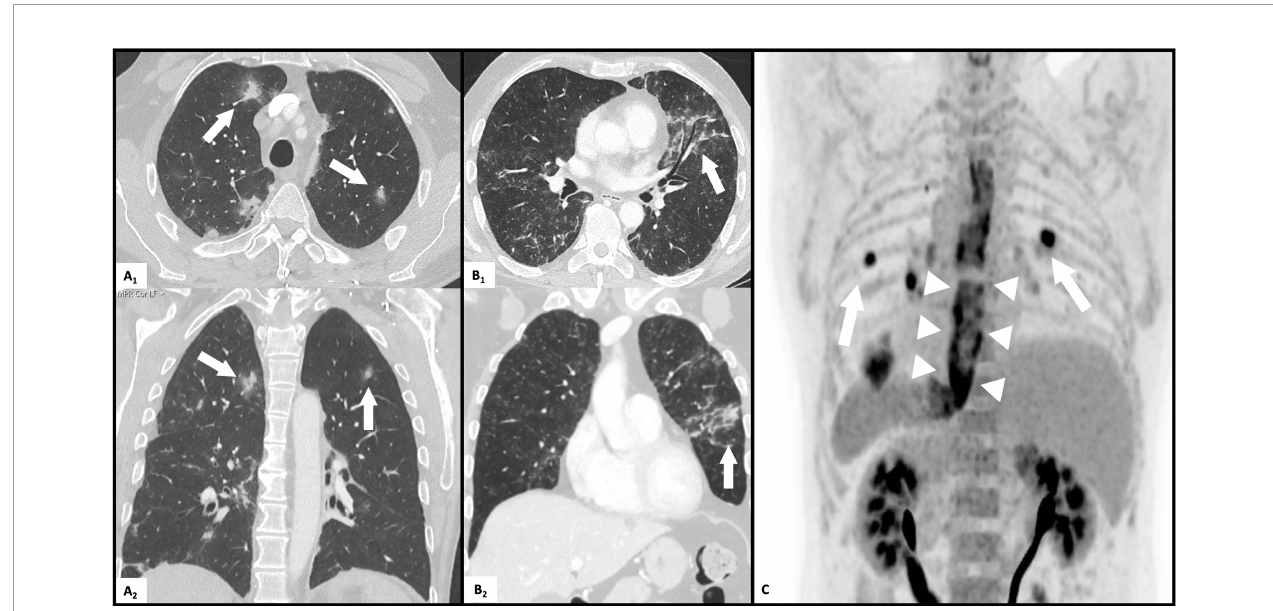
FIGURE 2 | Pulmonary and esophageal affection on CT-scans. (A) multifocal nodular pulmonary in fi ltrates (arrows) on transverse (A 1 ) and coronal (A 2 ) high resolution CT scan. (B) diffuse pulmonary in fi ltrates (arrows) on transverse (B 1 ) and coronal (B 2 ) high resolution CT scan. (C) FDG-PET-CT scan: diffuse esophageal (arrowheads) tracer uptake and multiple pulmonary nodules